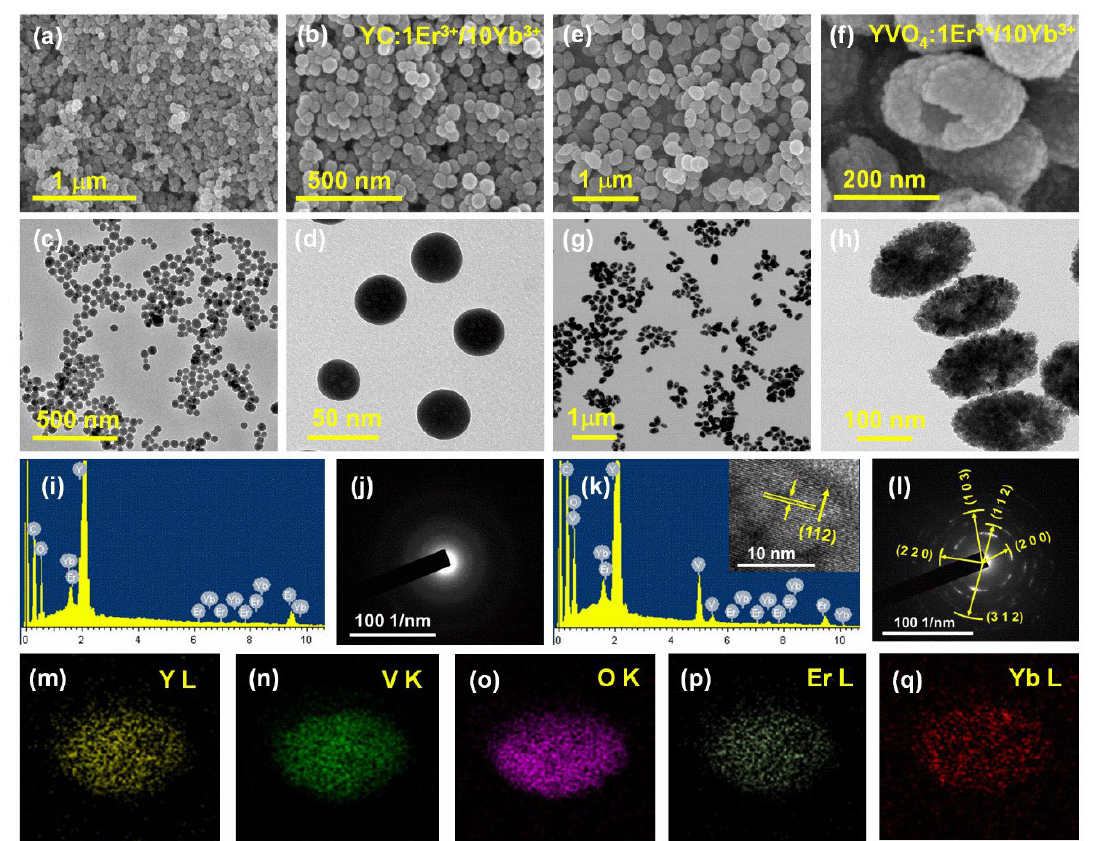
Figure 1. FE-SEM and FE-TEM images of ( a – d ) YC:Er 3+ /Yb 3+ NSs and ( e – h ) YVO 4 :Er 3+ /Yb 3+ UC- MHNSPs. ( i , k ) EDS spectrum and ( j , l ) SAED patterns of NSs and UC-HMNSPs, respectively, and the inset of ( k ) shows the corresponding HR-TEM image. ( m – q ) Elemental mapping of an individual YVO 4 :Er 3+ /Yb 3+ UC-MHNSPs based on EDS spectrum.